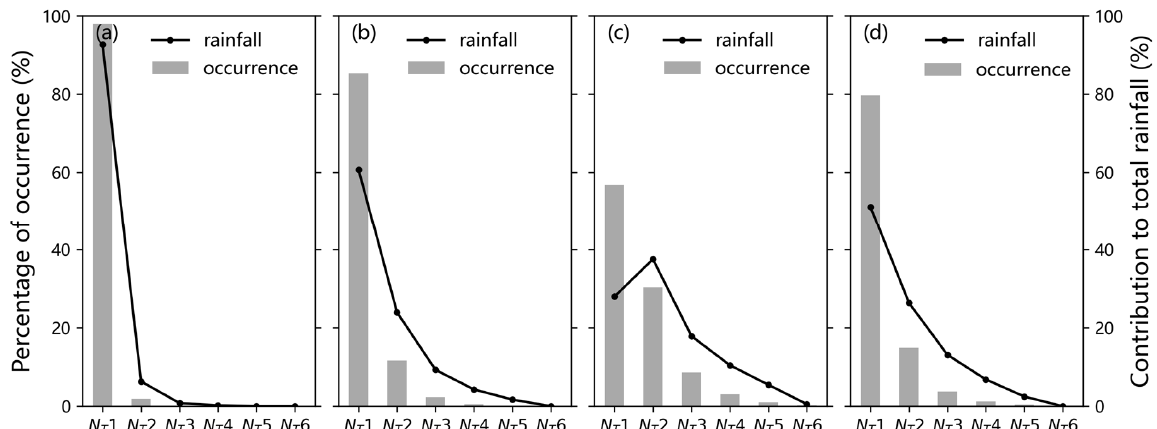
Figure 8. Percentages of occurrence (bar) and relative contributions to the total rainfall (line) from the different N T bins in the four seasons: winter ( a ), premonsoon ( b ), monsoon ( c ) and postmonsoon ( d ).